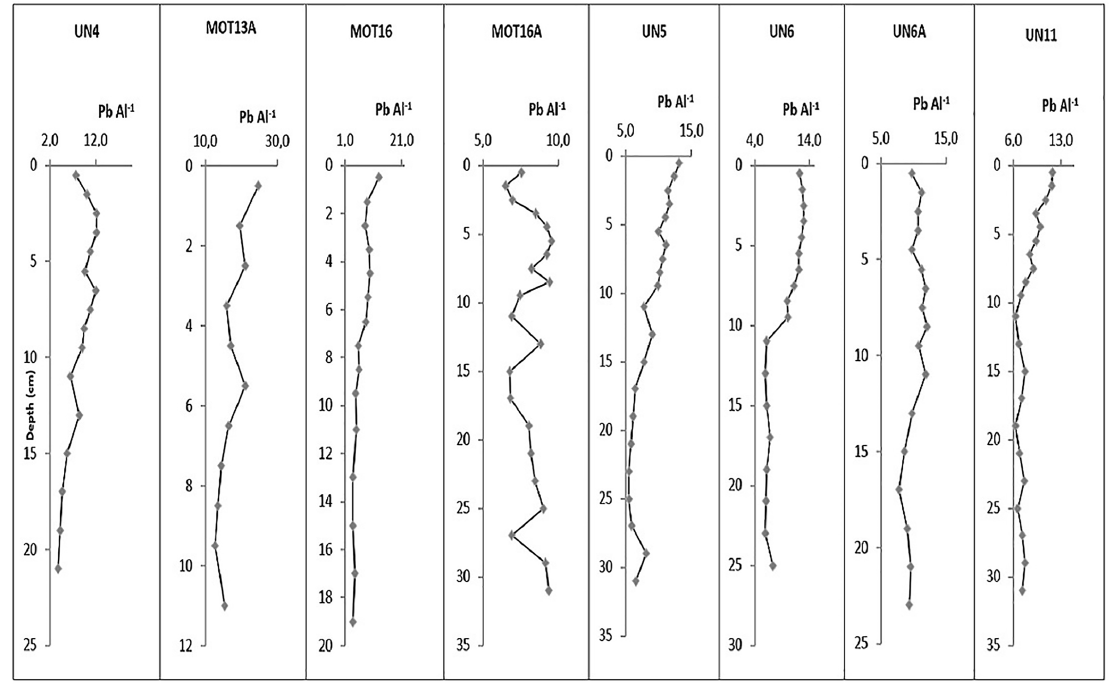
Figure A13. Vertical distributions of Pb Al − 1 × ( 10 4 ) in sediment cores. The ratios in the coarse cores MOT13A, MOT16 and UN4 are calculated at the fine-sediment fraction ( < 63µm).